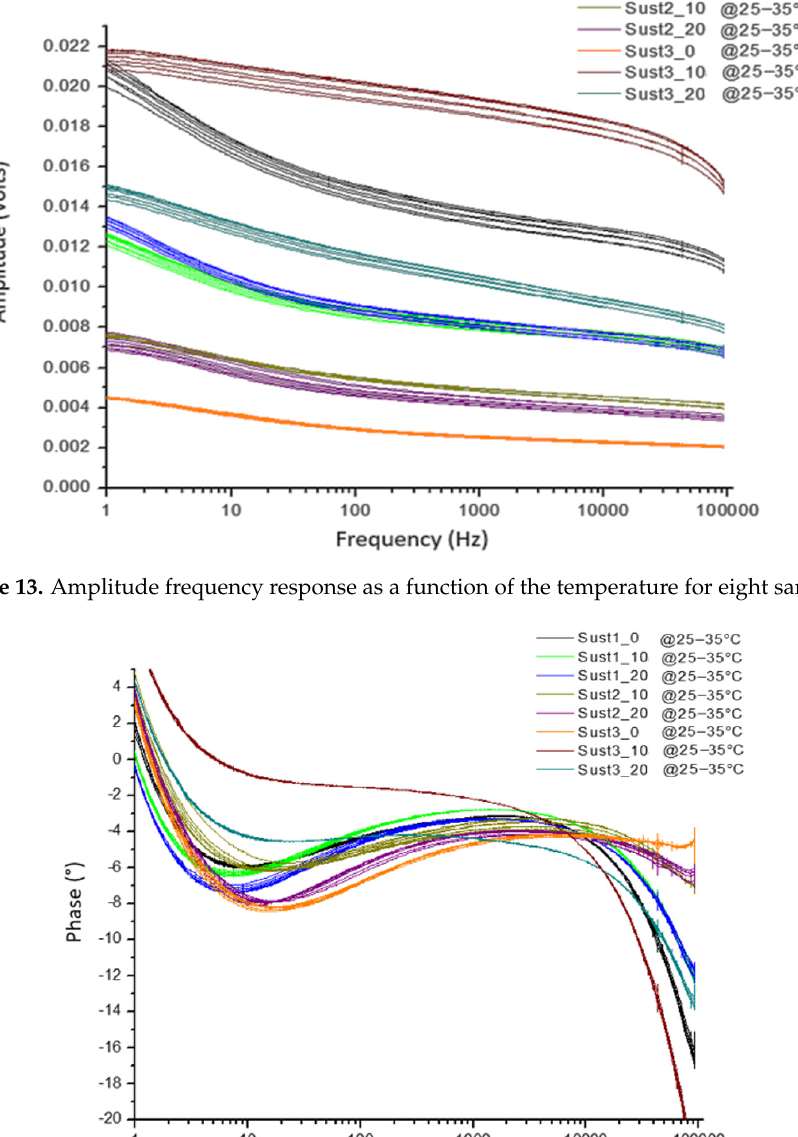
Figure 14. Phase frequency response as a function of the temperature for eight samples.